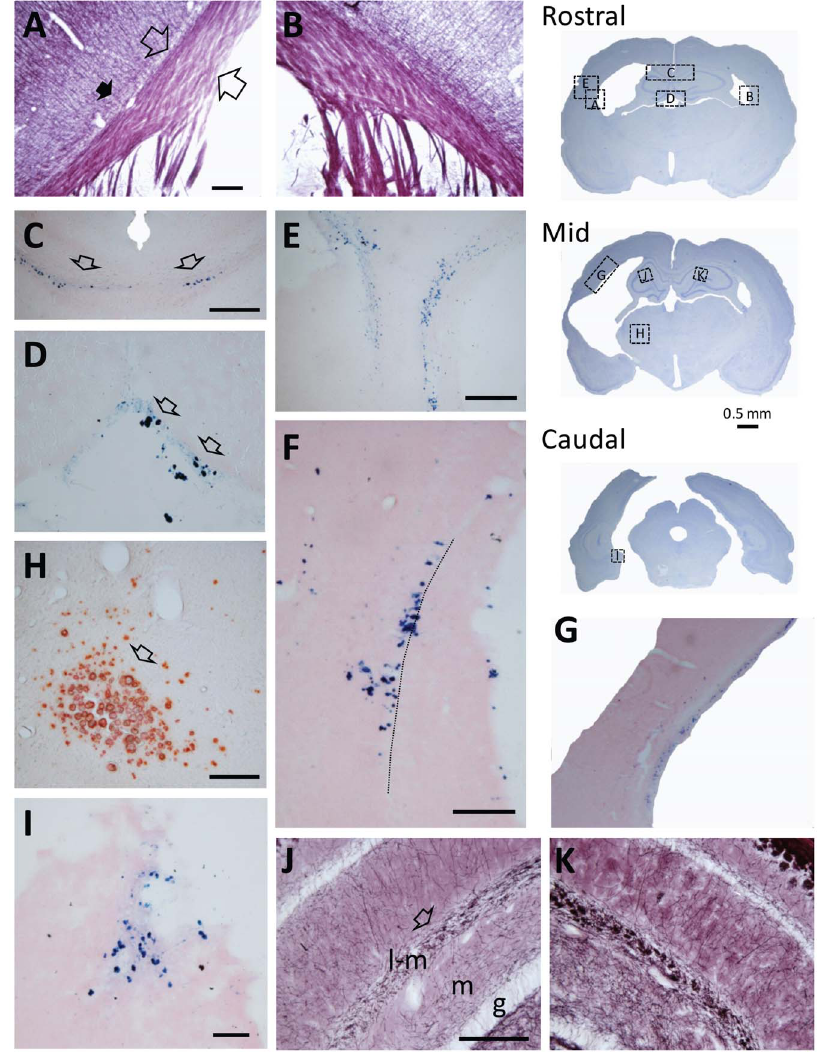
Figure 4. Summary of pathological findings in animals with lateral FPI. Three thionin-stained whole brain coronal sections on the right show the approximate location, from which panels A-K were taken. Rostro-caudal level of sections corresponds to the level of MRI slices ( A ) Myelin- stained section demonstrating a reduced thickness of white matter (fiber bundle between the open arrows) and in particular, reduction in the density of fibers in layer VI (black arrow) of the S1 region ipsilaterally. ( B ) Note a thicker white matter band contralaterally and abundance of myelinated fibers in layer VI. The pattern of staining is comparable to that in sham-operated controls (not shown). ( C ) Perl-stained sections showing iron deposits in corpus callosum bilaterally (open arrows). ( D ) Iron deposits in plexus choroideus (open arrows). ( E ) Iron deposits in cortical lesion and deep portion of the cortex near white matter band. ( F ) Iron deposits in the subgranular region of the dentate gyrus. Dashed line indicates the border between the granule cell layer and the hilus. ( G ) Iron deposits in subcortical white matter on the lesion side. ( H ) Alizarin-stained calcifications in the ipsilateral thalamus (open arrow). ( I ) Iron deposits in the parasubiculum. ( J ) Myelin staining from the ipsilateral hippocampus showing a reduced density of fibers in the stratum lacunosum-moleculare of the CA1 (open arrow) compared to contralateral hippocampus. Contralaterally ( K ) the pattern of staining is comparable to that in sham-operated controls (not shown). Abbreviations: g, granule cell layer; m, molecular layer; l-m, stratum lacunosum molecular of CA1; p, pyramidal cell layer. Scale bars equals in panels A–F, H–K 100 m